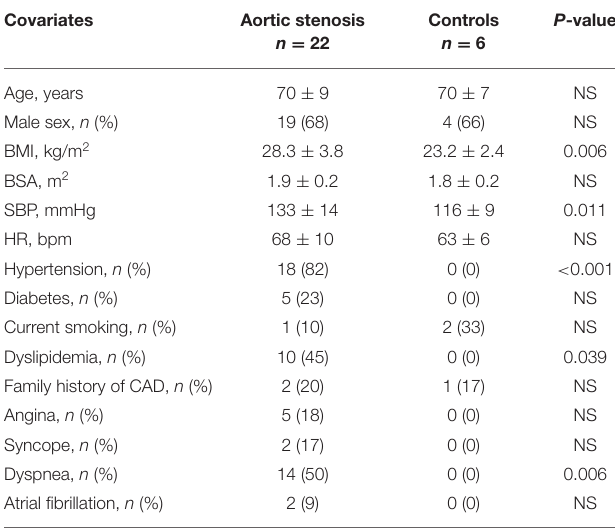
TABLE 1 | Baseline clinical and demographic characteristics of the study population. Covariates Aortic stenosis n = 22